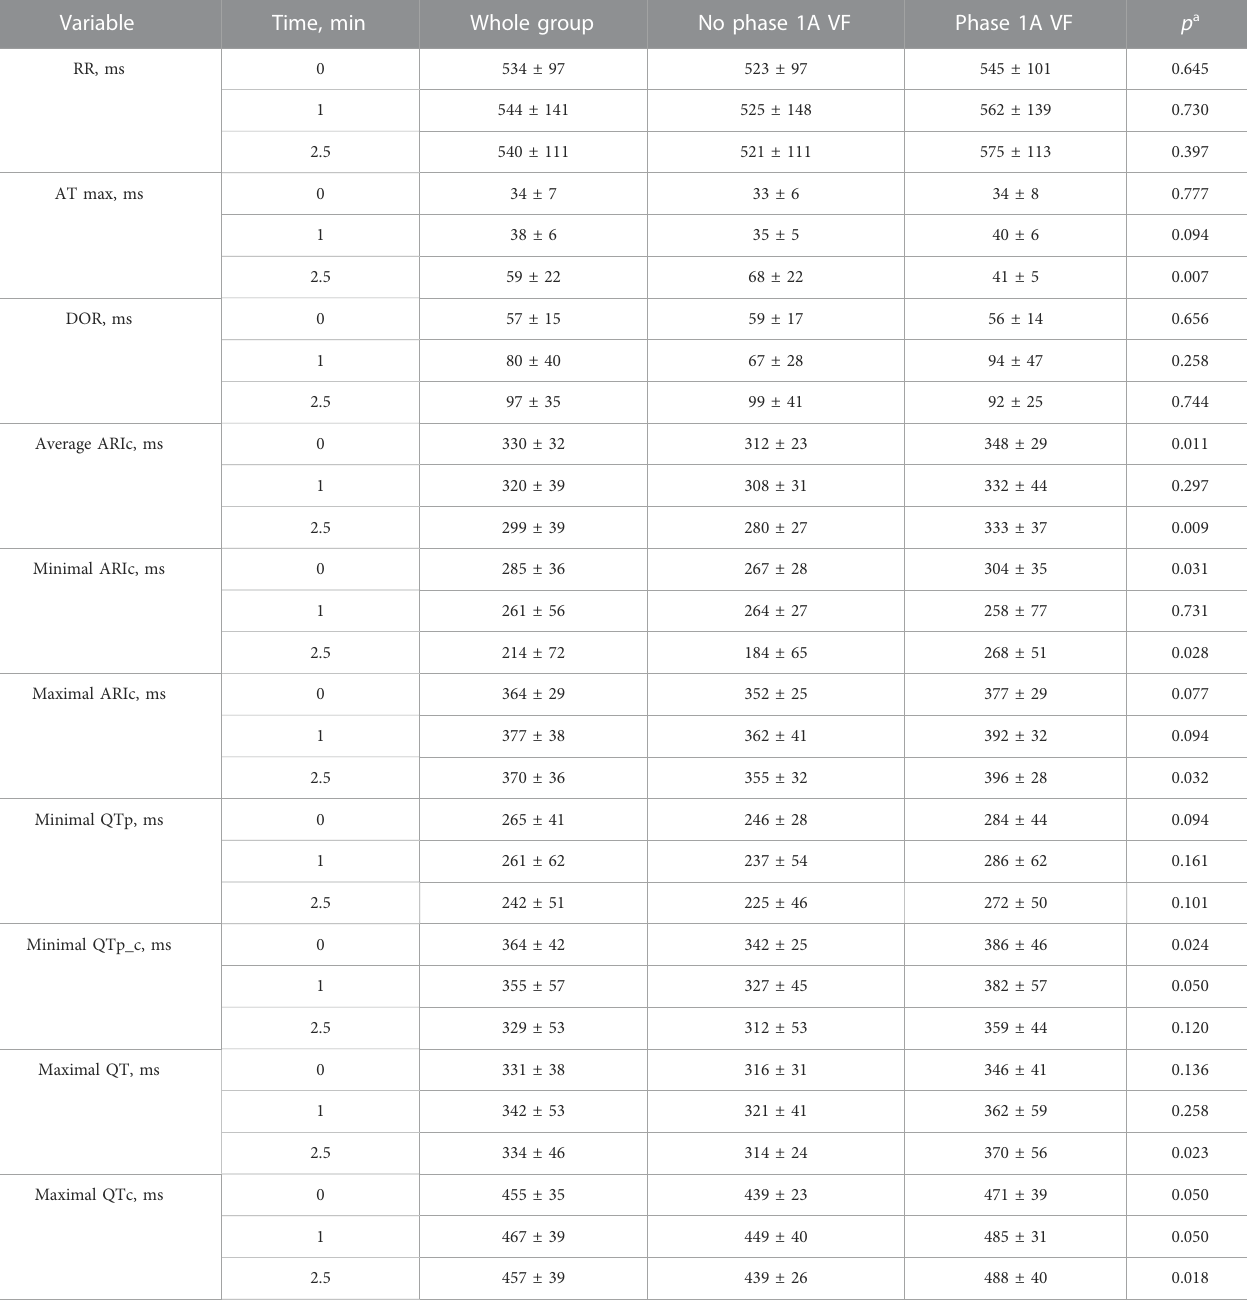
TABLE 1 Epicardial mapping and ECG characteristics (Mean ± SD) in the studied groups.